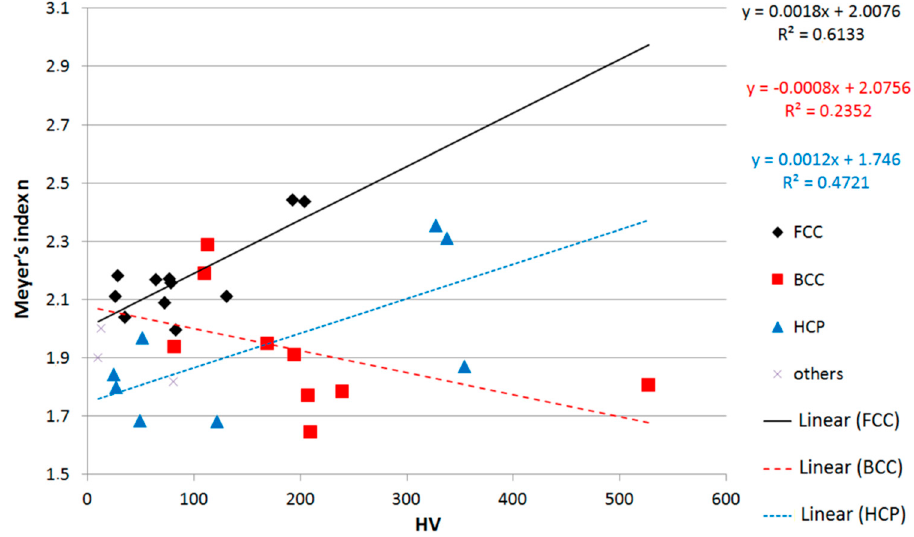
Figure 2. The relationship between micro-hardness average hardness HV and Meyer’s index n.